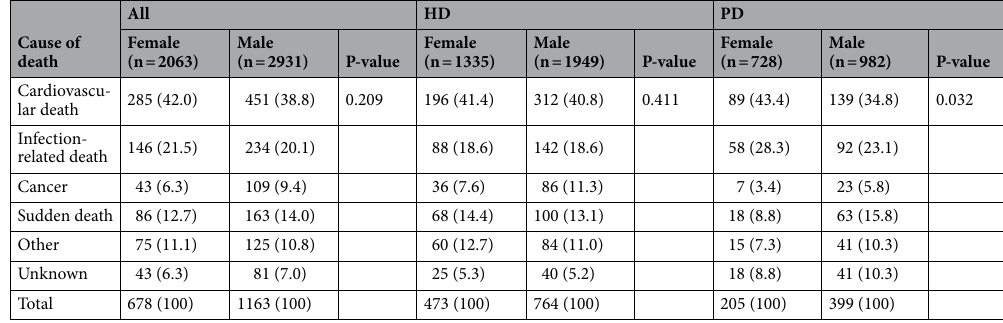
Table 2. Causes of death. Values are given as n (%). HD hemodialysis, PD peritoneal